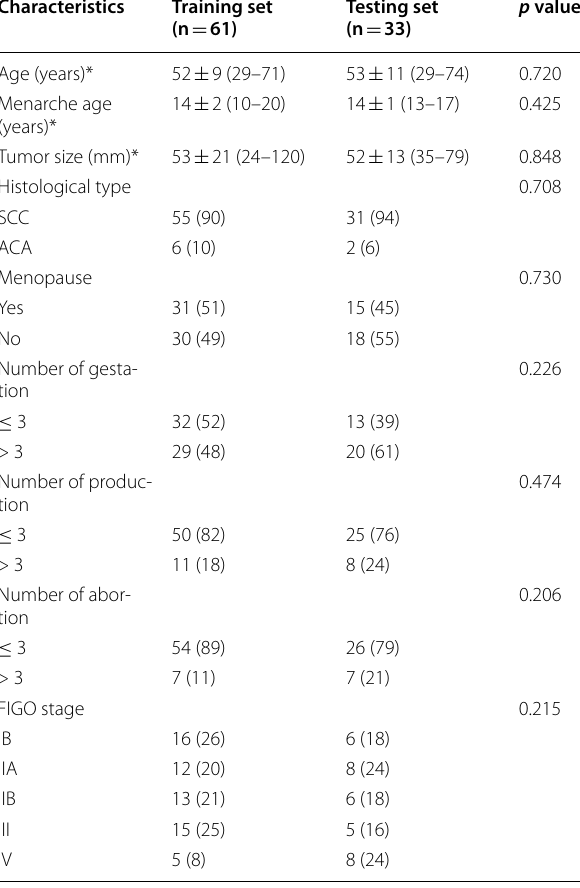
Table 2 Clinical characteristics of the patients in the training and testing sets